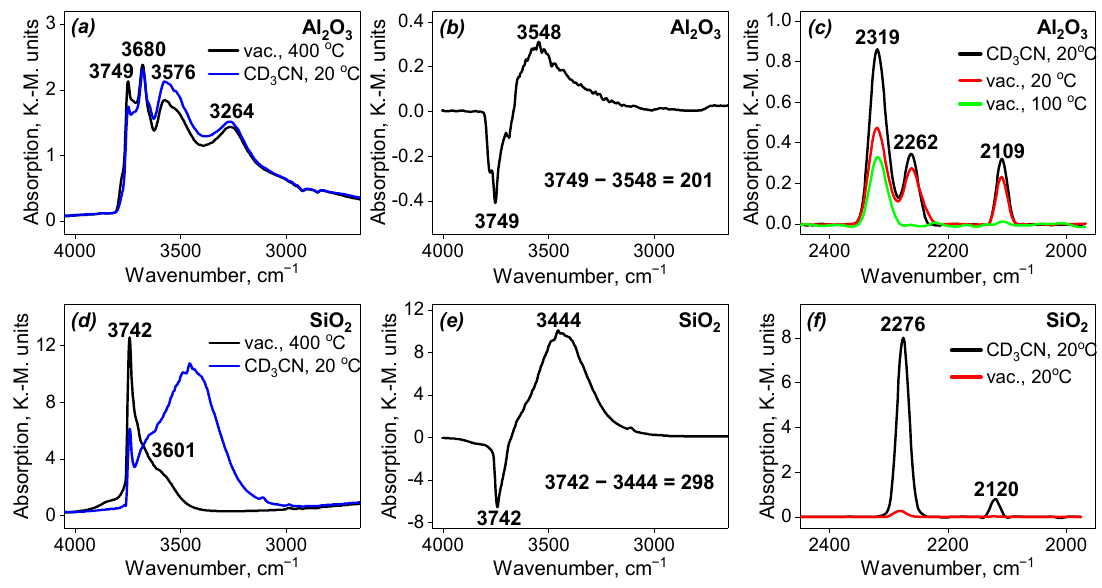
Figure 9. Spectra of single-component supports: ( a , d ) DRIFT-OH after evacuation and after adsorp- tion of CD 3 CN; ( b , e ) difference of the DRIFT-OH spectra before and after adsorption of CD 3 CN; ( c , f ) DRIFT-CD 3 CN adsorption-desorption spectra of the support. Table 2. The assignment of DRIFT spectroscopy bands in the region of OH groups.